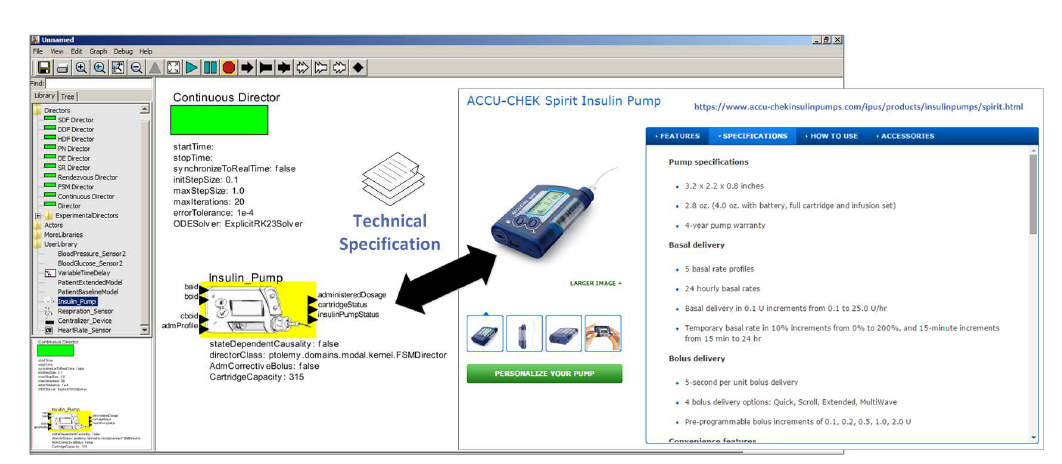
Figure 16. Selecting a Device Model in the Ptolemy